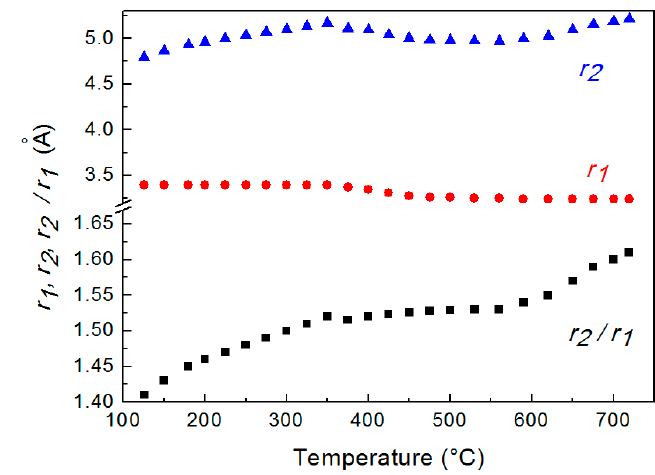
Figure 3. Average distances r 1 and r 2 of 1st and 2nd nearest neighbors determined from G ( r ) at different temperature and their ratio r 2 / r 1 . The scale is enlarged in the lower part of the graph to evidence r 2 / r 1 variations.